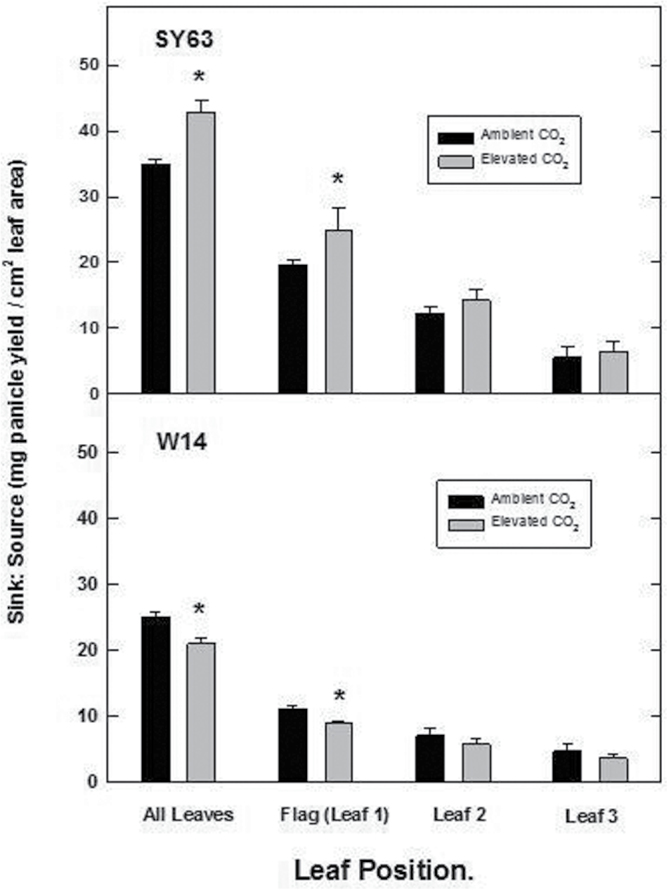
The carbon source:sink ratio (mg of panicle to cm2 of leaf area) for the uppermost three leaves (averaged and individual) for the rice cultivars SY63 and W14 grown at ambient and elevated [CO2]. The ratio was determined from shading of individual leaves (source) and measurement of panicle biomass (sink) from post-anthesis through individual grain maturity (R4–R8 using the system of Counce et al., 2000). Asterisk(s) indicate a significant differences for a given cultivar as a function of [CO2]. See the Materials and methods for additional details. **P<0.01; *P<0.05; bars are ±SD.